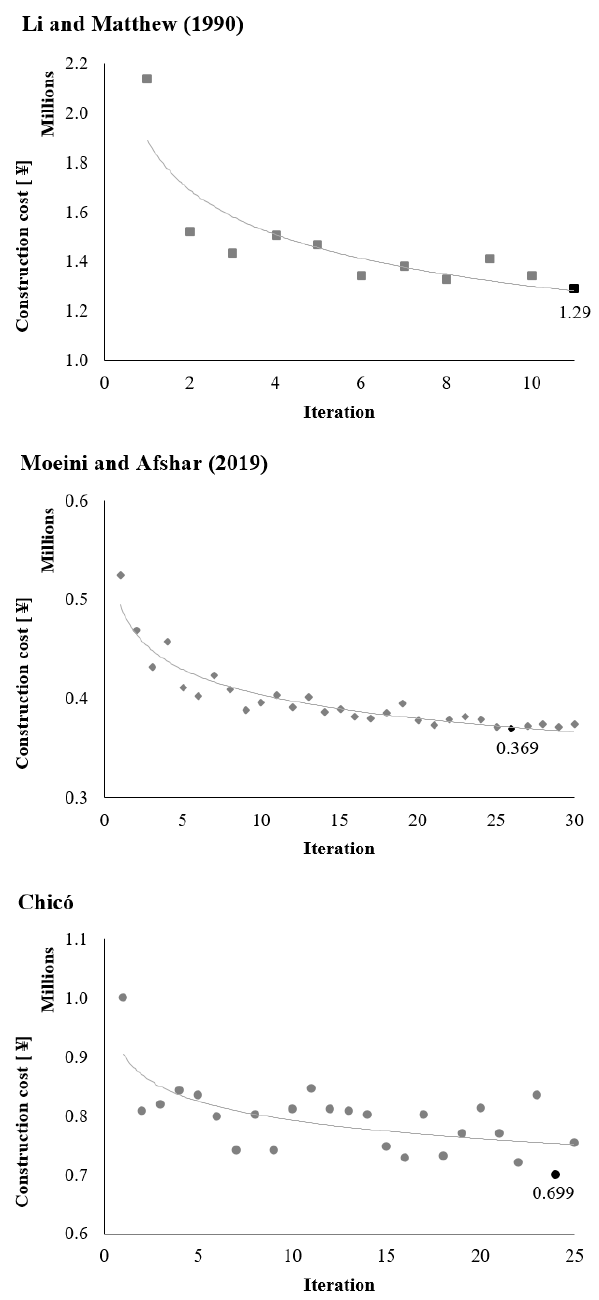
Figure 8. Convergence curves for each case study concerning construction costs.